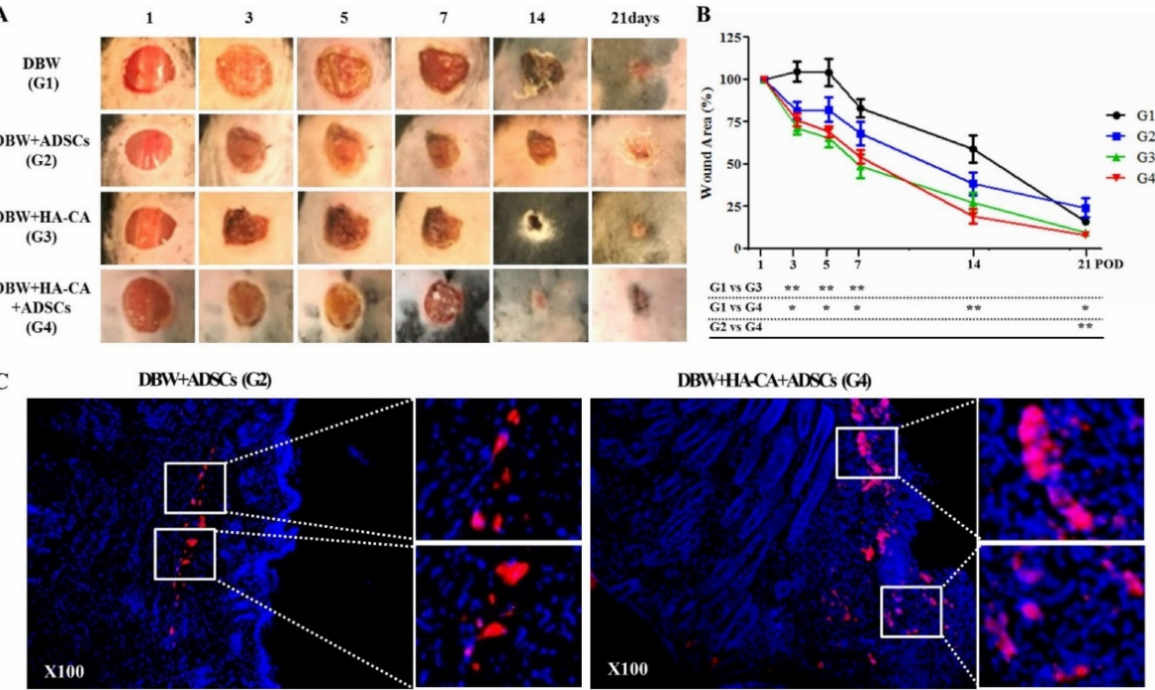
Figure 1. Effects of catechol-modified hyaluronic acid (HA-CA)/adipose-derived stem cells (ADSC) treatment on mouse diabetic wounds (DBW). ( A ) Wounds 6 mm in diameter were produced by punch biopsy, and the wound size was monitored on digital photographs using ImageJ on days 1, 3, 5, 7, 14, and 21. Compared with the DBW control group, the wound sizes were reduced from postoperative day (POD) 3 in mice treated with ADSCs or HA-CA. In particular, wound healing was accelerated after POD 7. The wounds of diabetic mice treated with HA-CA + ADSCs exhibited the fastest healing. ( B ) The fraction of the initial wound size was analyzed with ImageJ software. Compared with control mice, diabetic mice treated with HA-CA or HA-CA + ADSCs had significantly higher wound healing rates up to POD 7. After POD 7, HA-CA + ADSC-treated mice exhibited the fastest wound healing. The data are expressed as means ± standard error of the mean (SEM; * p < 0.05, ** p < 0.01; n = 8–10 mice per group). ( C ) ADSCs were stained with PKH26 red fluorescent dye to enable transplanted cell tracking. In contrast to the ADSC group, large numbers of PKH26-labeled ADSCs were detected in the epidermis, papillary dermis, and reticular dermis at the wound site in the HA-CA + ADSCs group (5 × 10 5 cells/100 µ L). Magnification: ×